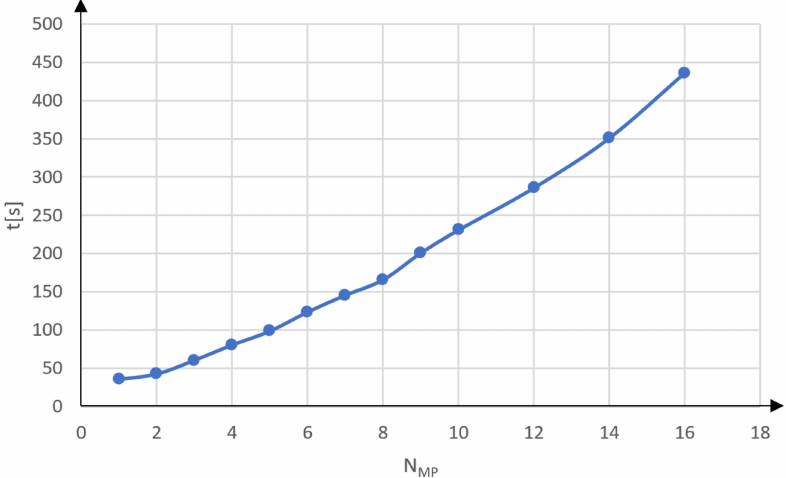
Figure 16. The effect of the size of the manufacturing island on the time required for